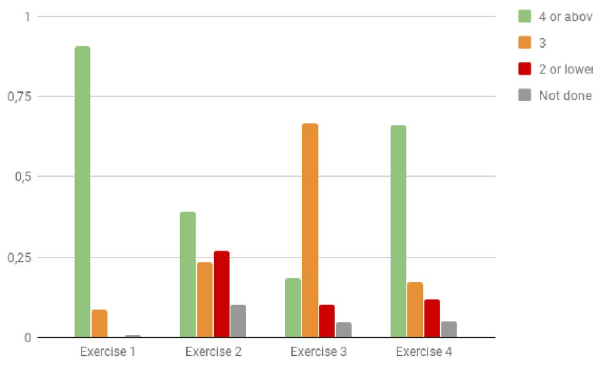
Fig. 9 Results obtained for variant 2—avatar-guided session. In graphs a, b the blue bars represent the average score obtained for the corresponding item, with the black arrows representing the